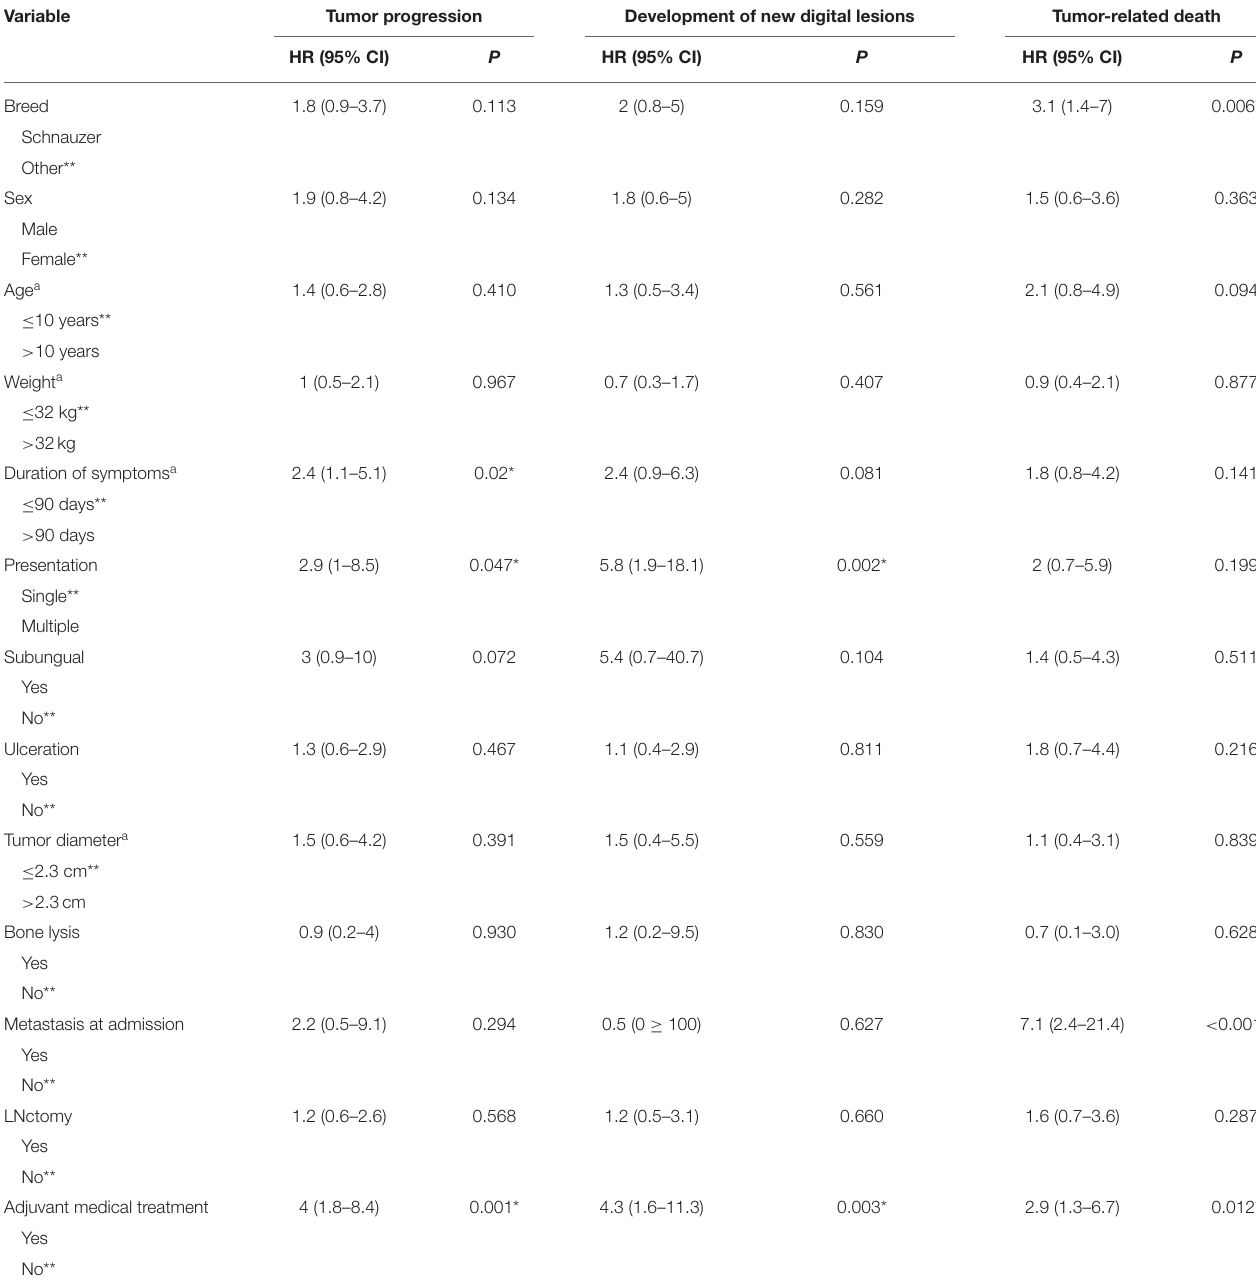
TABLE 2 | Univariable Cox regression analysis of variables potentially associated with increased risk of tumor progression, de novo tumor development and survival time in 79 dogs with digital squamous cell carcinoma.